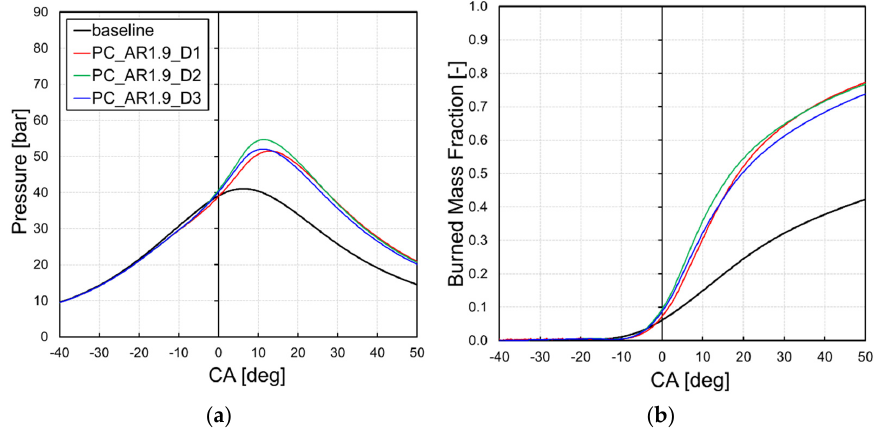
Figure 19. Influence of the orifice diameter on the ( a ) in-cylinder pressure trend and ( b ) burned mass fraction evolution with air-fuel equivalence ratio of 1.4.